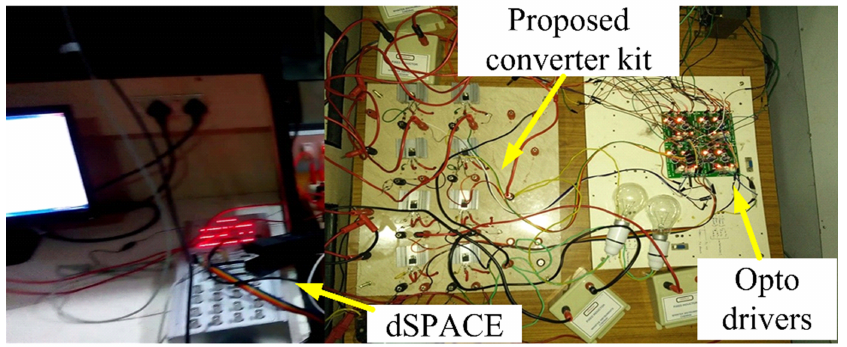
Figure 15. Hardware